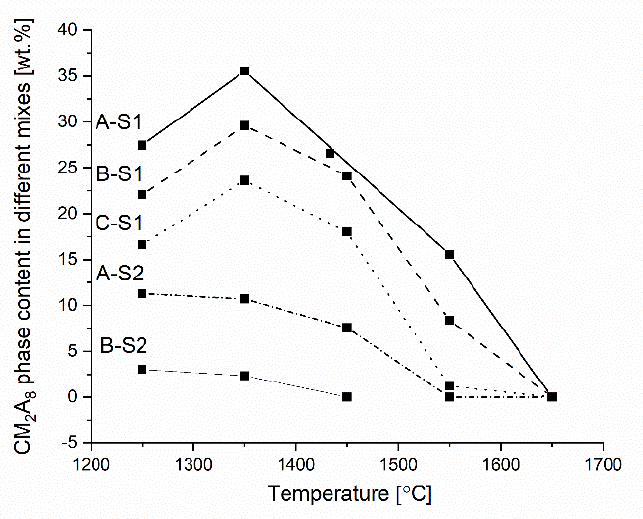
Figure 5. Thermodynamic predictions of the CM 2 A 8 solid phase of the reactive mixtures A_S1, B_S1, C_S1, A_S2, and B_S2 versus increasing temperature.